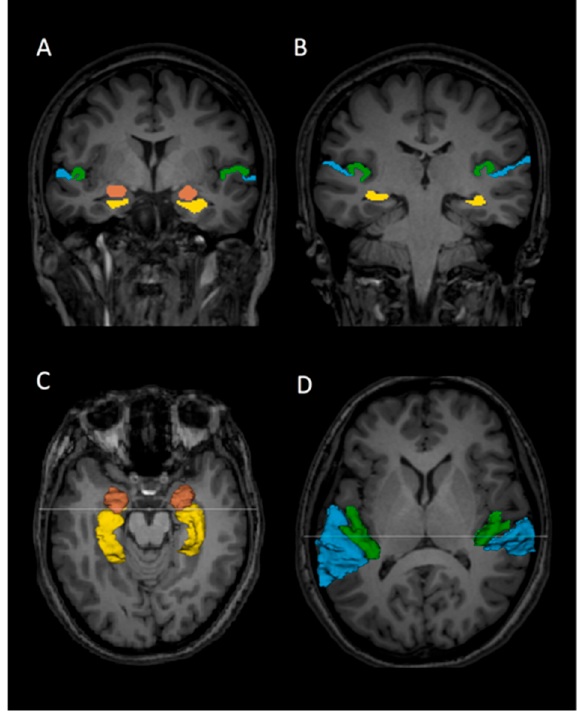
Figure 1. Delineation of Heschl’s gyrus (HG), planum temporale (PT), hippocampi, and amygdalae on 3 Tesla magnetic resonance imaging slices in a healthy subject. The HG (green), PT (blue), hippocampus (yellow), and amygdala (brown) regions of interest are outlined. ( A , B ): Coronal view of the HG, PT, hippocampi, and amygdalae. ( C ): Three-dimensional (3D) reconstruction of the hippocampi and amygdalae superimposed onto an axial slice. ( D ): 3D reconstruction of HG and PT gray matter superimposed onto an axial slice. The lines on C and D correspond to the coronal slices of A and B , respectively.